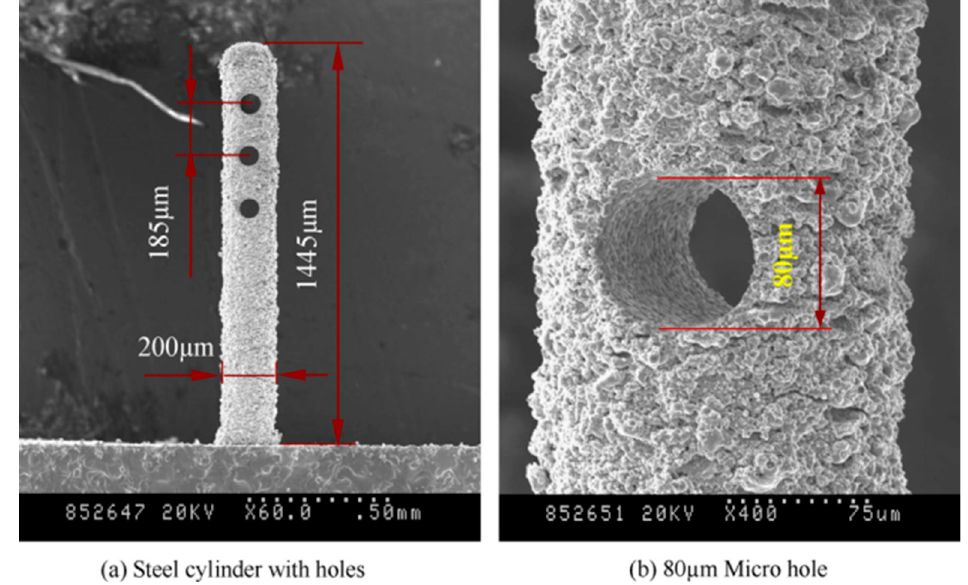
Figure 15. Selective removal of micro-EDM drilling: ( a ) steel cylinder with holes; ( b ) 80-µm micro-hole [206].